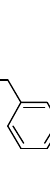
Figure 2. Structure of ligand 6 .